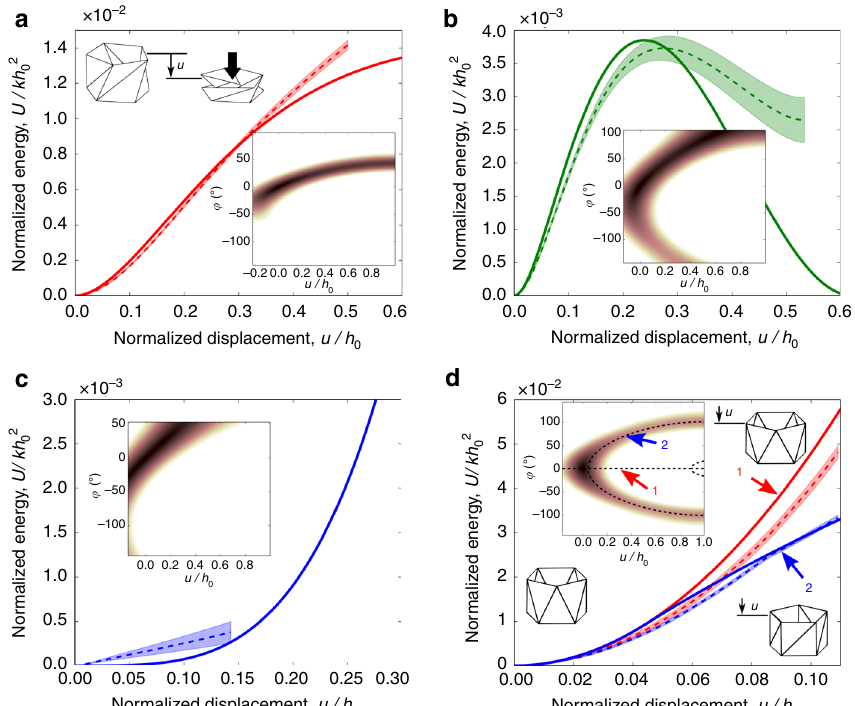
Fig. 2 Folding behaviors of the TCO cells. a – d The energy analysis for the TCO-based truss structures shows remarkably different behaviors: a Monostability at ( h 0 , θ 0 ) = (90 mm, 46°); b bistability at (150 mm, 40°); c zero-stiffness mode at (140 mm, 92°); and d bifurcation at (119 mm, 0°). The displacement is normalized by h 0 , and energy is normalized by kh 2 . Experimental results (mean value is shown as dashed curves , and s.d. is represented by 0 colored areas ) show qualitative agreements with the analytical predictions ( solid curves ). The inset plots show the equi-potential plots of U = kh 2 as a function 0 of u / h 0 and φ , in which highlighted trajectories indicate the valley of minimum potential energy. In the experimental curves, the range of u / h 0 is restricted by the folding motions of the TCO-based truss prototypes (Supplemental Movie 3). For example, the highly twisted shape of the zero-stiffness TCO prototype (Fig. 1g) causes the truss elements overlap in the early stage of folding, allowing only ~15% of u / h 0 as shown in the panel c . The